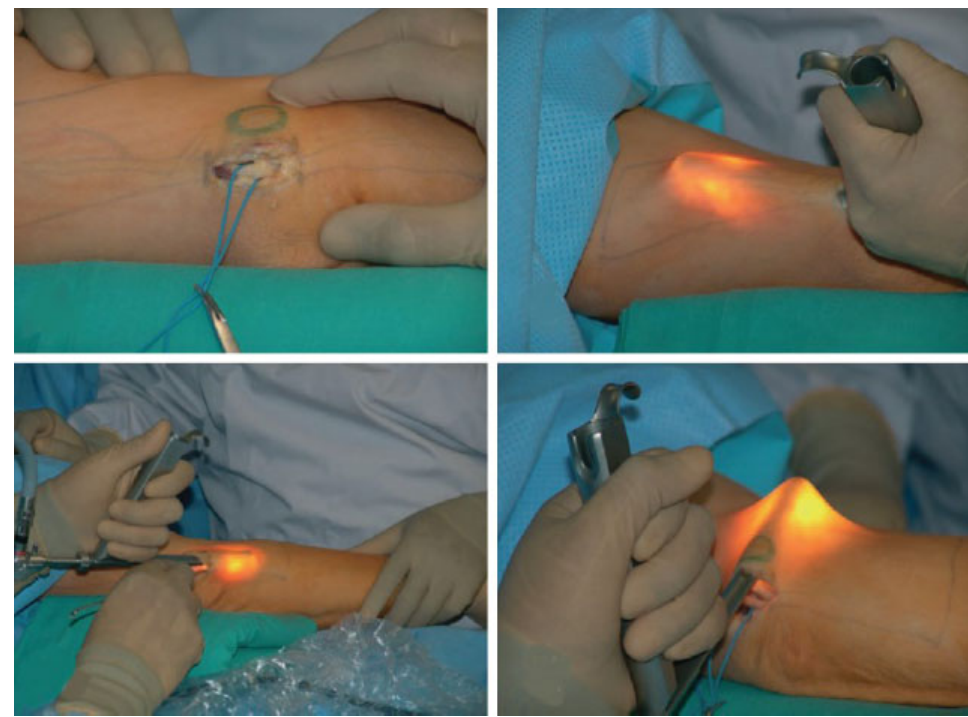
Fig. 5 Endoscopic cubital tunnel release. 25